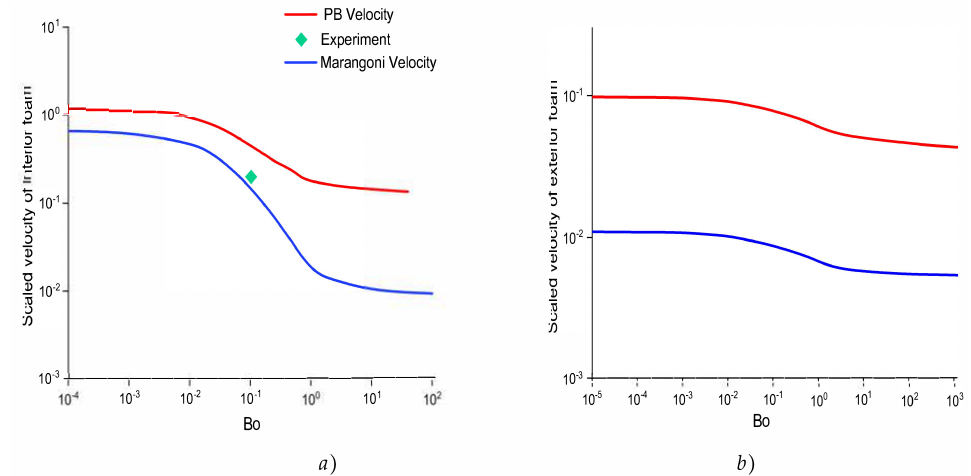
Figure 7. ( a ) Influence of Bo numbers on both the Marangoni and PB velocities for interior foam. The resulting curve corresponded with the experiments [21]. ( b ). Influence of Bo numbers on the Marangoni and PB velocities in the exterior